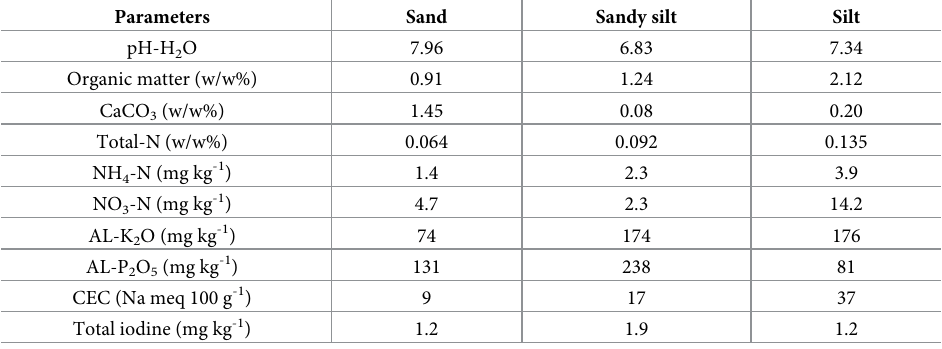
Plant cultivation and treatment. Plants were grown in a greenhouse (Experimental Sta- tion of the Centre of Agricultural Research in O˝ rbottya´n, Hungary), and received natural light. The environmental parameters (temperature, humidity, light intensity) were continuously monitored during the growing period and the measured data has been summarized in Table 2. Seedlings were planted in plastic pots (size: 10 L). At the bottom of all pots, a 4–8 mm thick layer of gravel was placed, which was covered by a synthetic fibrous fabric on which 10 kg of soil was layered. In each pot, three plants were cultivated. For the experiments, three soil types Table 1. Physical-chemical properties of